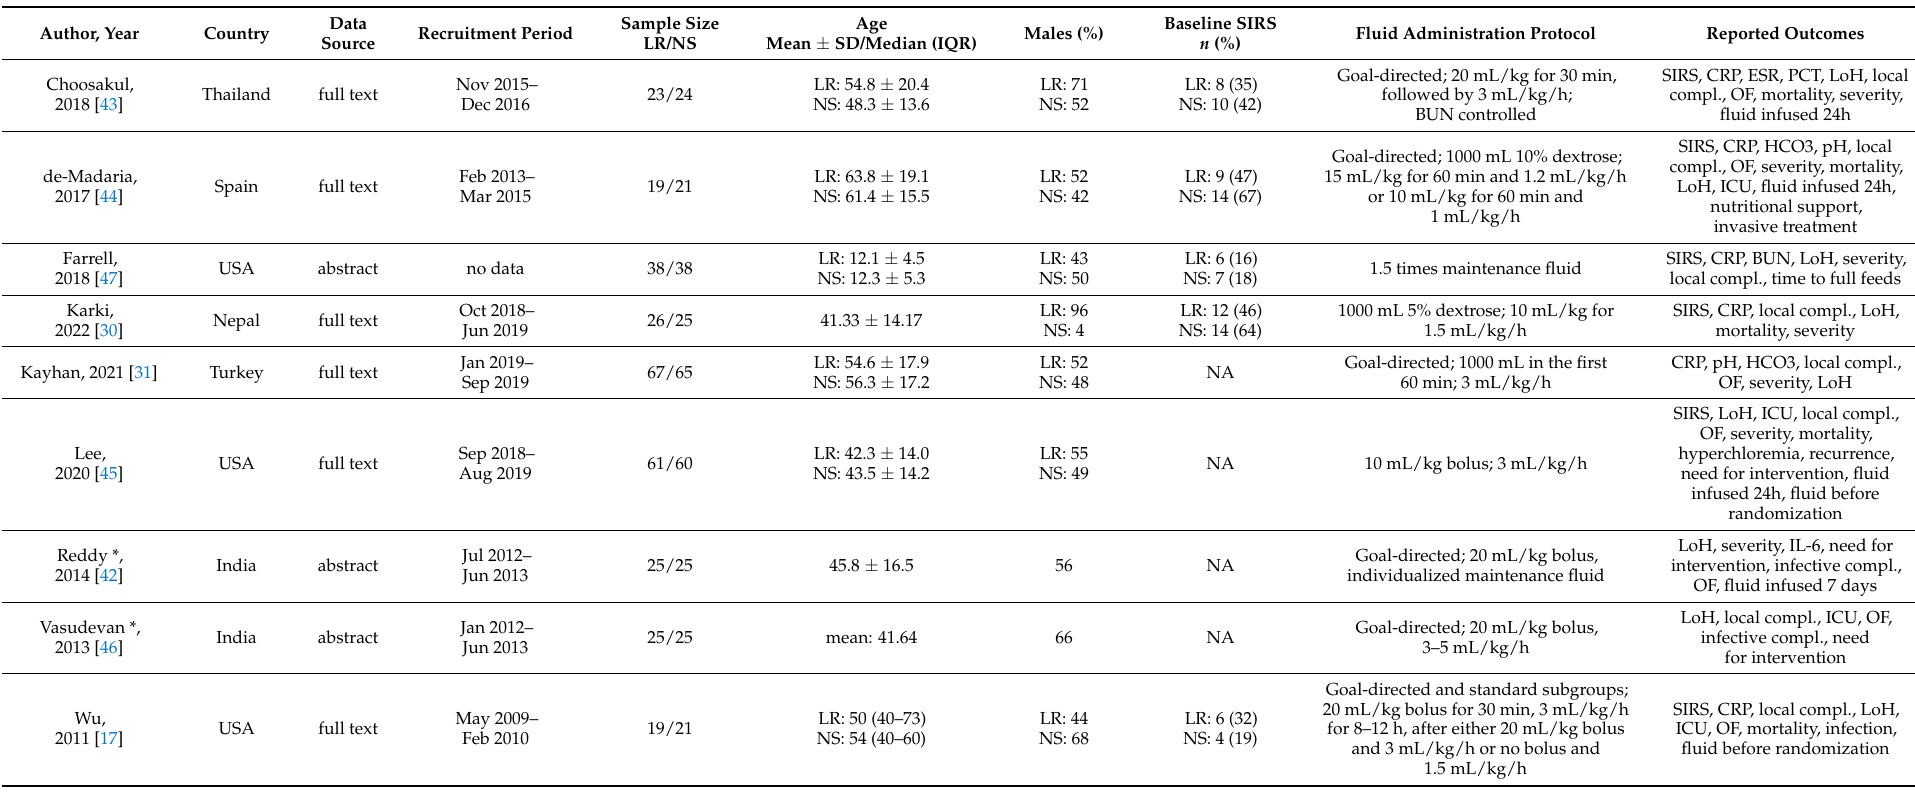
Table 1. Main characteristics of the included studies *: the abstracts published by Vasudevan and Reddy et al. refer to the same RCT, hence the total number of patients analyzed is 557. Abbreviations: LR: lactated Ringer’s solution; NS: normal saline; SD: standard deviation; IQR: interquartile range; SIRS: systemic inflammatory response syndrome; CRP: C-reactive protein; ESR: erythrocyte sedimentation rate; PCT: procalcitonin; LoH: length of hospitalization; OF: organ failure; HCO3: bicarbonate; ICU: need for intensive care; BUN: blood urea nitrogen; IL-6: